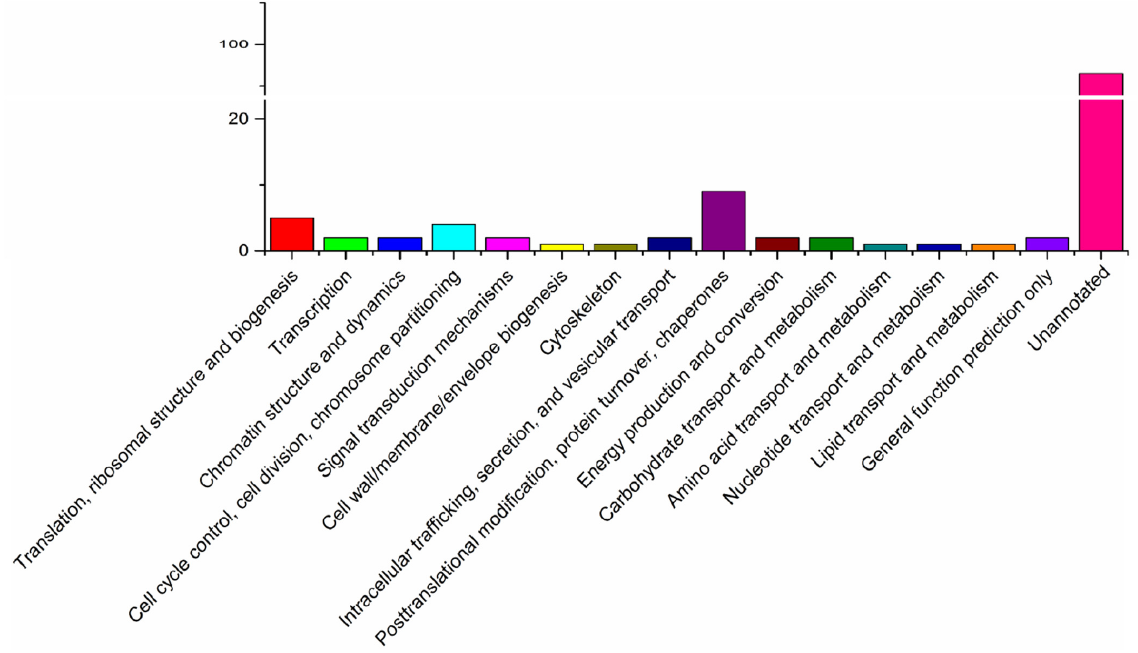
Figure 4. COG annotation of surface proteins of Enterocytozoon hepatopenaei spores.